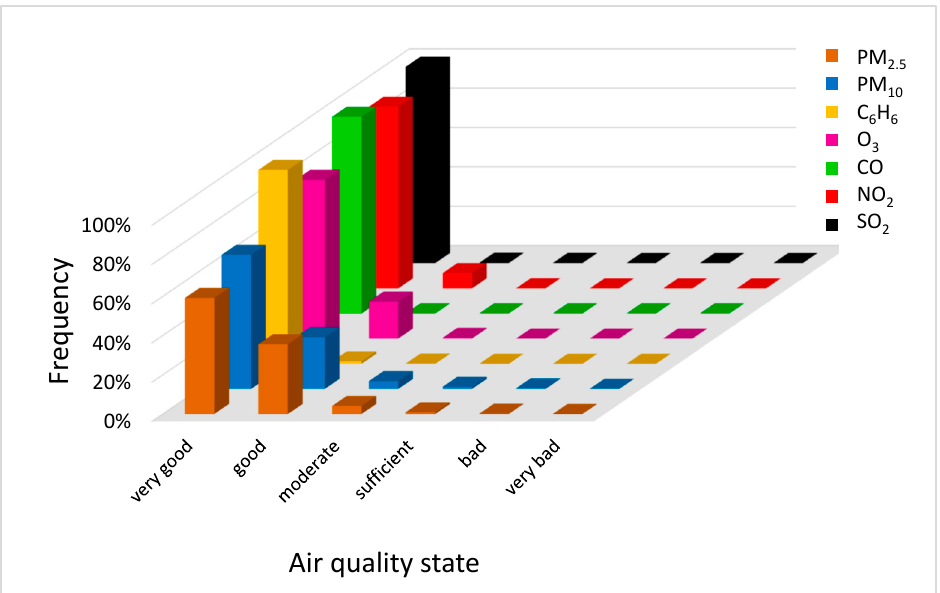
Figure 2. Frequency of particular air pollutants at air quality states (the Gda ń sk agglomeration, years 2015–2021). Source: Own study based on data of the Chief Inspectorate for Environmental Protection [58].